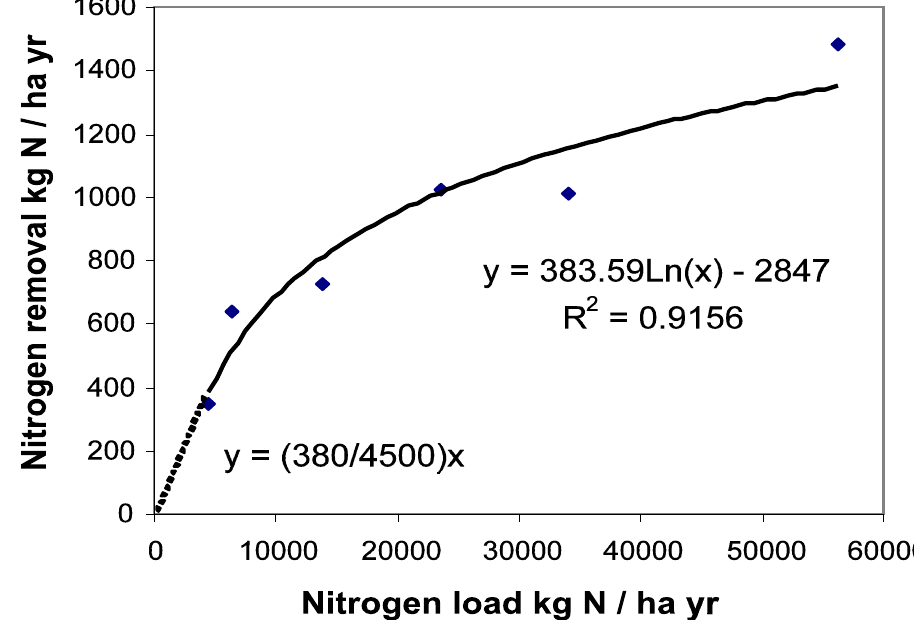
Figure B1. Relationships between nitrogen load and removal (kg per hectare wetland area and year), used in an earlier evaluation and based on data from automatic time or flow proportional water sampling in six created wetlands in agricultural areas in southern Sweden [39]. R = 380L/4500 was used for loads <4500 kg ha − 1 yr − 1 and R = 383.59ln(L) − 2847 was used for loads >4500 kg ha − 1 yr − 1 , where R = annual nitrogen removal per wetland area (kg ha − 1 yr − 1 ); L = annual nitrogen load per wetland area (kg ha − 1 yr − 1 ).